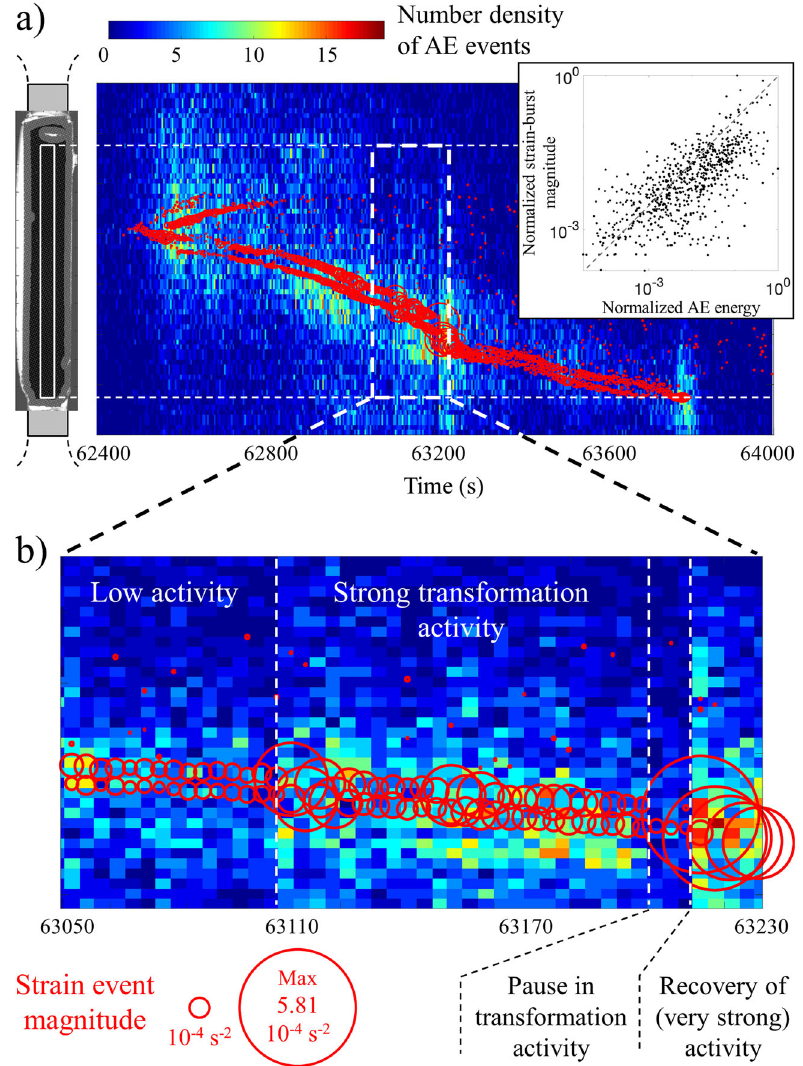
Fig. 6 Concurrent tracking of strain and AE avalanches in the sample during the phase transformation. a Superimposition of the strain avalanches in Fig. 4d onto the AE density map in Fig. 4b. Inset: correlation of strain-event magnitudes with pooled AE-event energies (normalised), when AE locations and strain avalanches are paired along the y -direction for each value of t . Pearson [Spearman] correlation is ~0.42 [~0.79]. b Temporal zoom highlighting details of the bursty phase transformation progress in the sample during the elongation